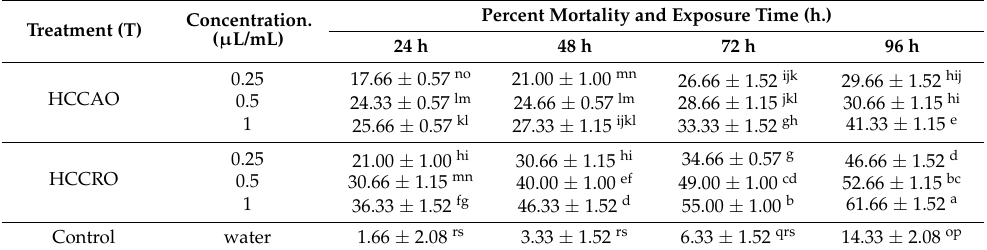
Table 2. Effect of essential oils on second-stage juveniles (J 2 ) of M. incognita at different